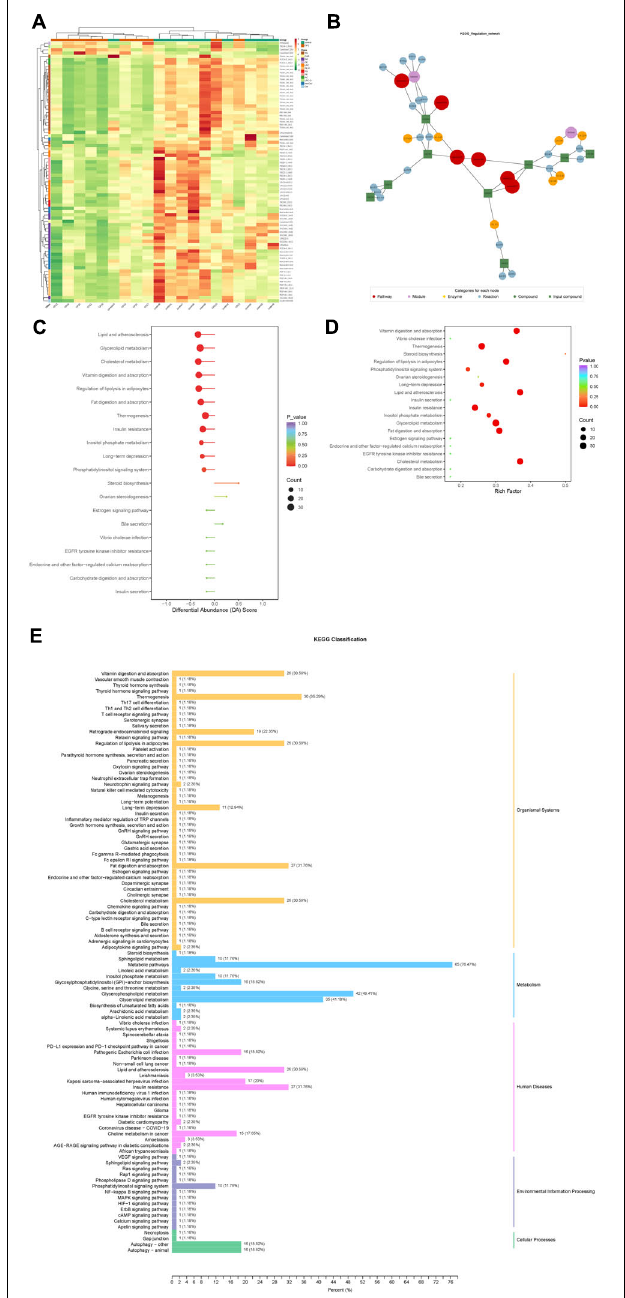
FIGURE 6 | (A) Clustering analysis for different metabolites of KEGG signaling pathway. (B) Analysis of the regulatory network for differential metabolites. (C) Differential abundance score of differential metabolic pathways. (D) KEGG enrichment map of differential metabolites. (E) KEGG enrichment analysis of differentially significant lipid